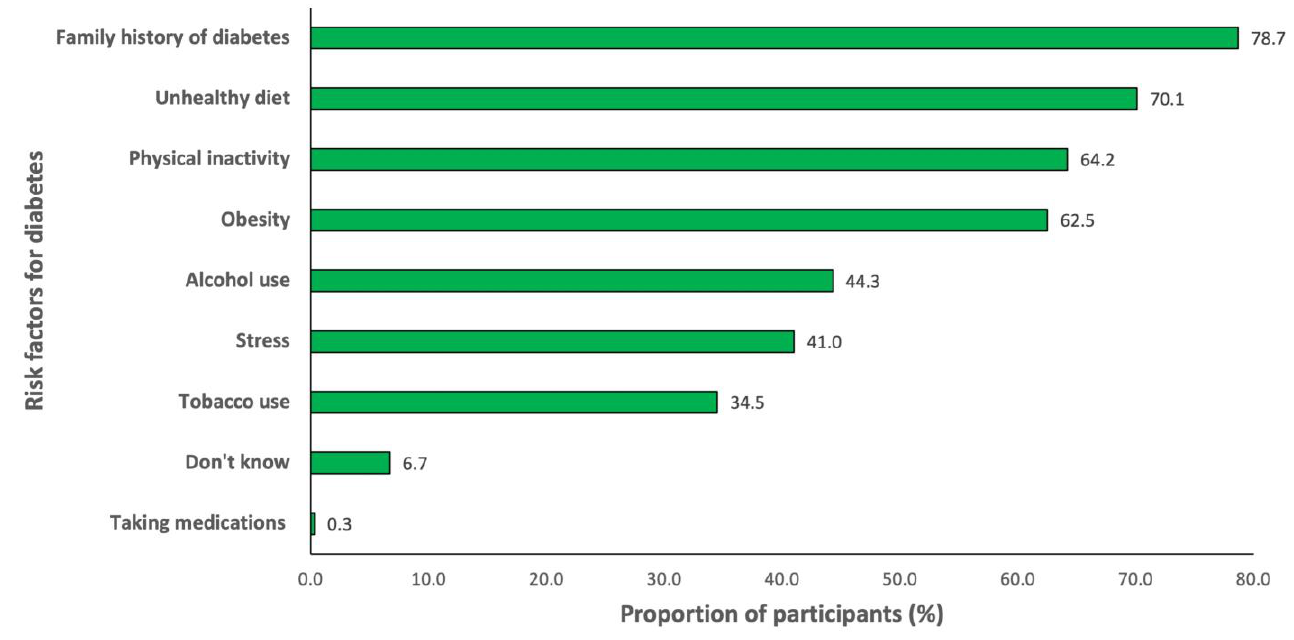
Figure 3. Knowledge of risk factors for type 2 diabetes.